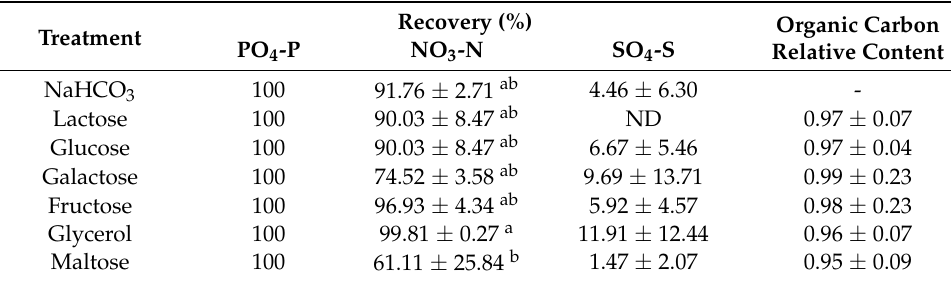
Table 4. Nutrient recovery and organic carbon relative content at the end of the cultivation period of the mixotrophic